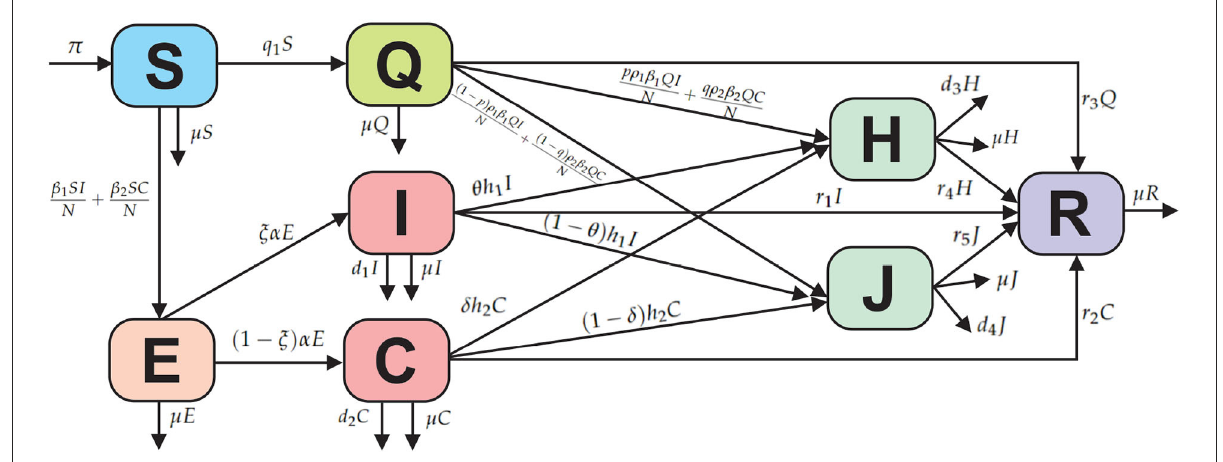
FIGURE1 Compartmental diagram of the COVID-19 model with comorbidity.